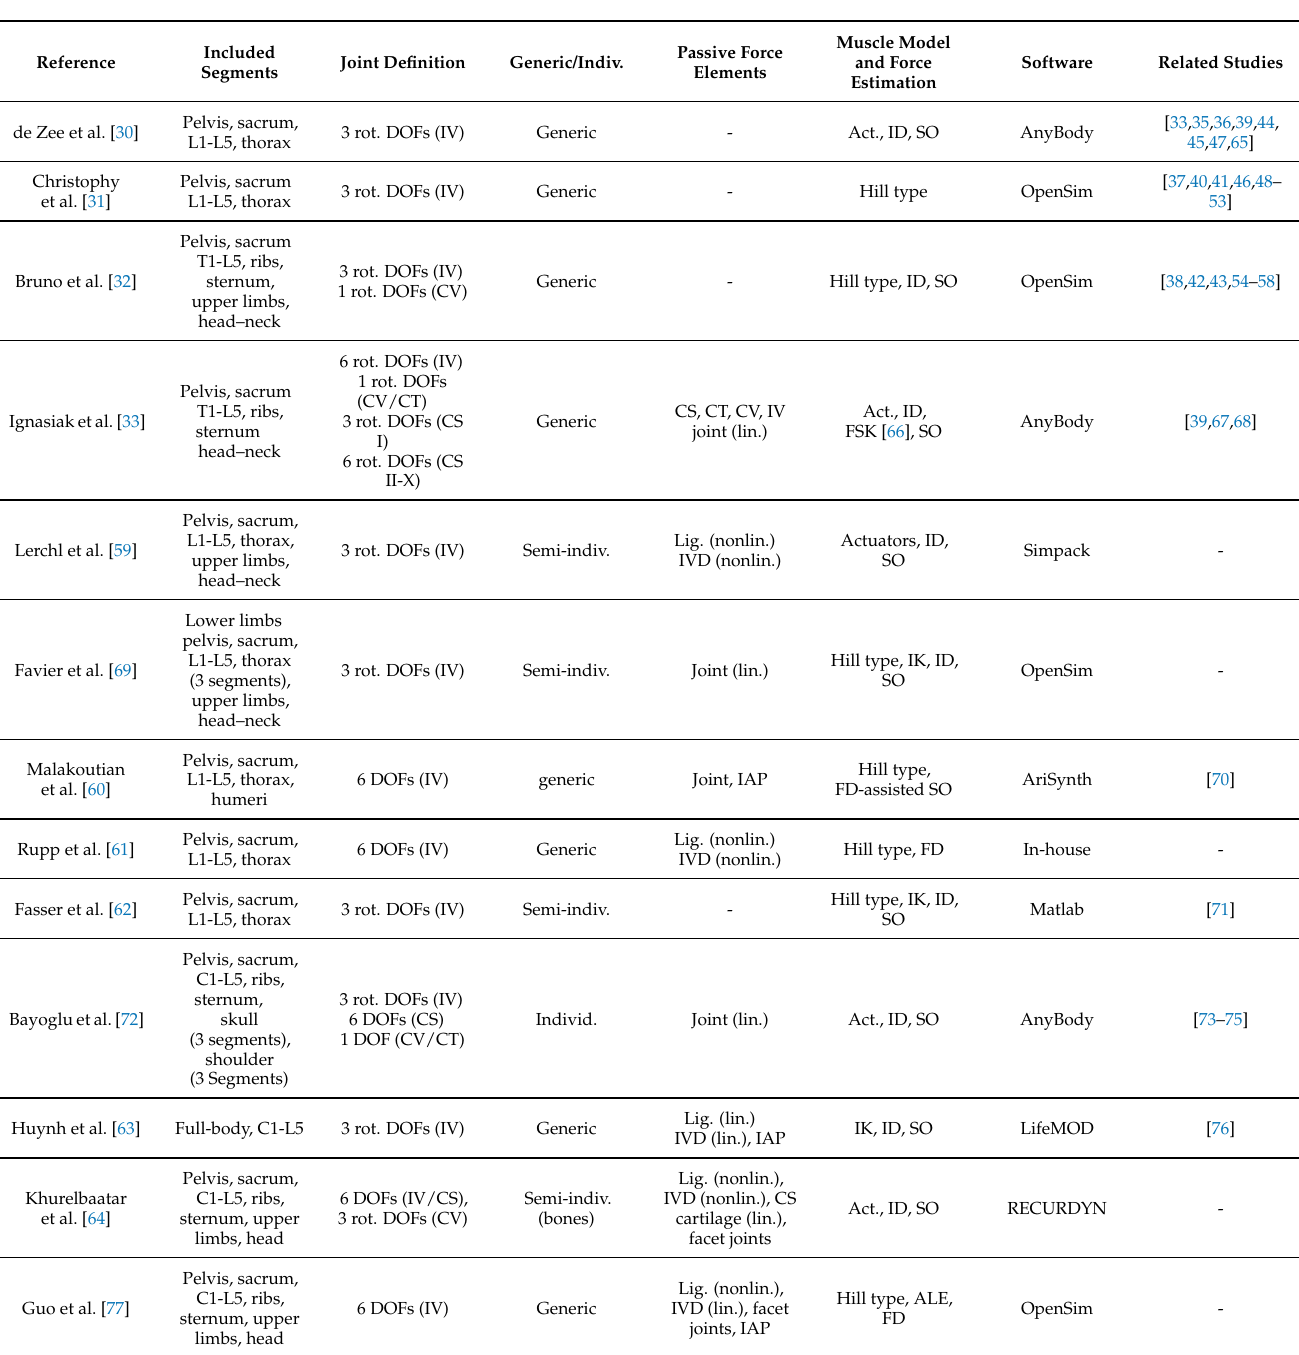
Table 1. Overview of original models of the musculoskeletal thoracolumbar spine and related modeling methods. Semi-individualized models are those that contain both individualized and generic musculoskeletal components. Joint definitions include potentially assigned